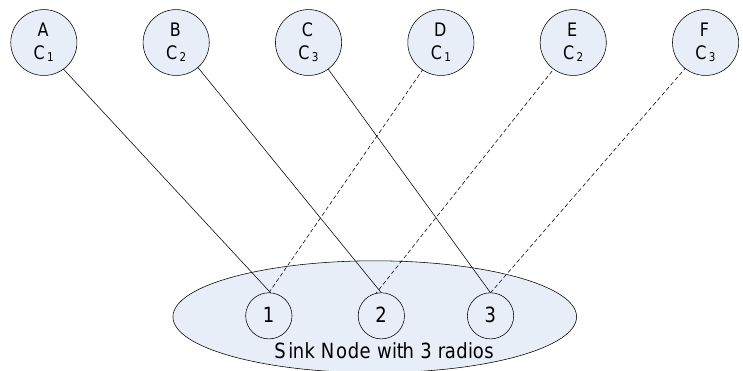
Figure 2. Sink Node with 3 Radios Receiving from 6 Transmitting Nodes on 3 non-overlapping channels (C1, C2,